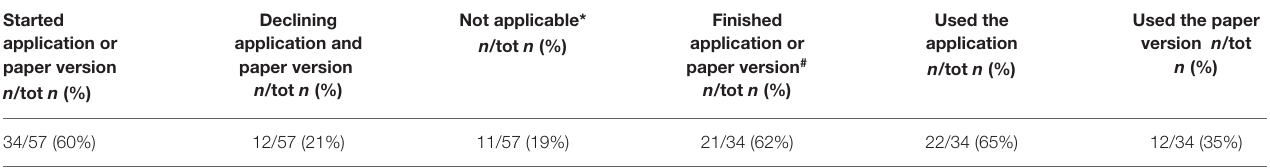
TABLE 4 | Percentage of patients delivering information on dietary fiber intake and acute side effects via an application (mobile phone or tablet) or paper version.